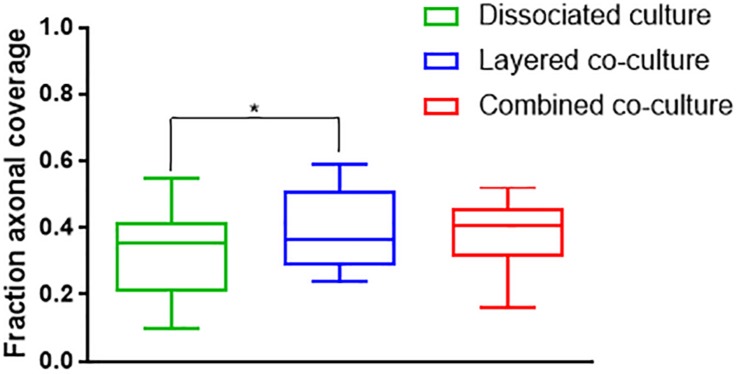
Assessment of average phosphorylated neurofilament coverage as fraction of total image area. Data acquired at 35 days in co-culture (n = 3, ∗p < 0.05).